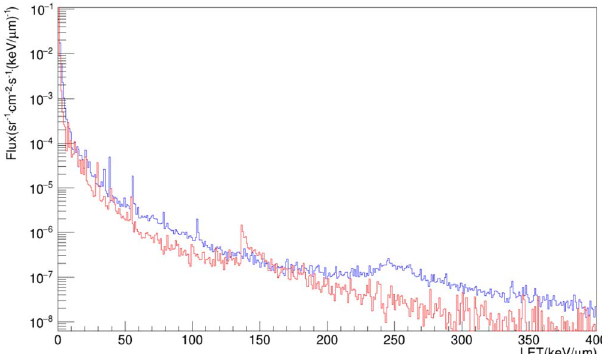
Fig. 6. LET H spectrum for the fi eld inside the spacecraft (red) and 2 O LET exp (Si) (blue). Both are calculated using the energy depositions in the pixel detectors of